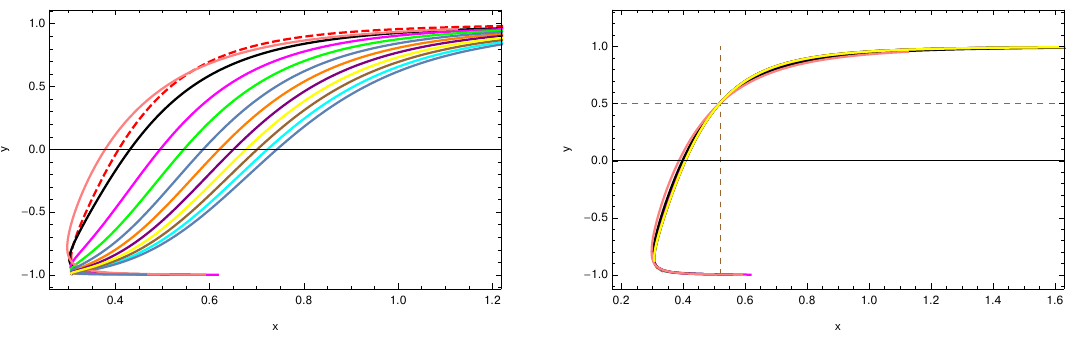
Figure 3 . Entropy densities s in conformal models, relative to the entropy densities of the UV (cid:12)xed points s UV at the corresponding temperature (see (1.8)), as functions of T= (black), CFT STU (blue), CFT PW ;m =0 (green) and CFT PW ;m = 1 (red). Left panel: vertical dashed lines indicate critical temperatures T crit separating thermodynamically stable and unstable phases of CFT PW ;m =0 (green) and CFT PW ;m = 1 (red) models. Right panel: the dashed black line is the small- T asymptote of the relative entropy in the CFT diag model, see (1.9).